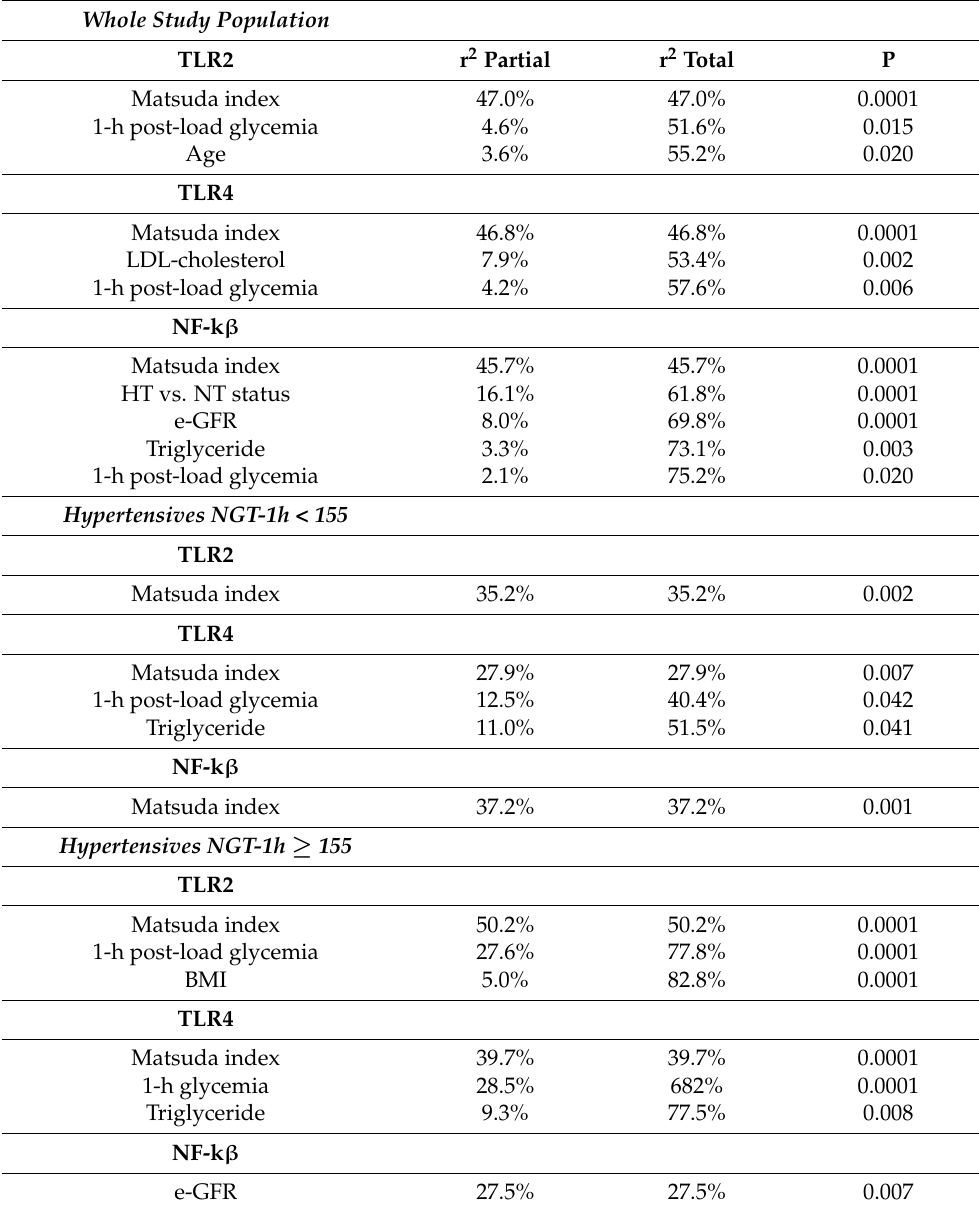
Table 4. Multiple regression analysis in the whole study population, in hypertensives NGT 1-h < 155, and NGT 1-h ≥